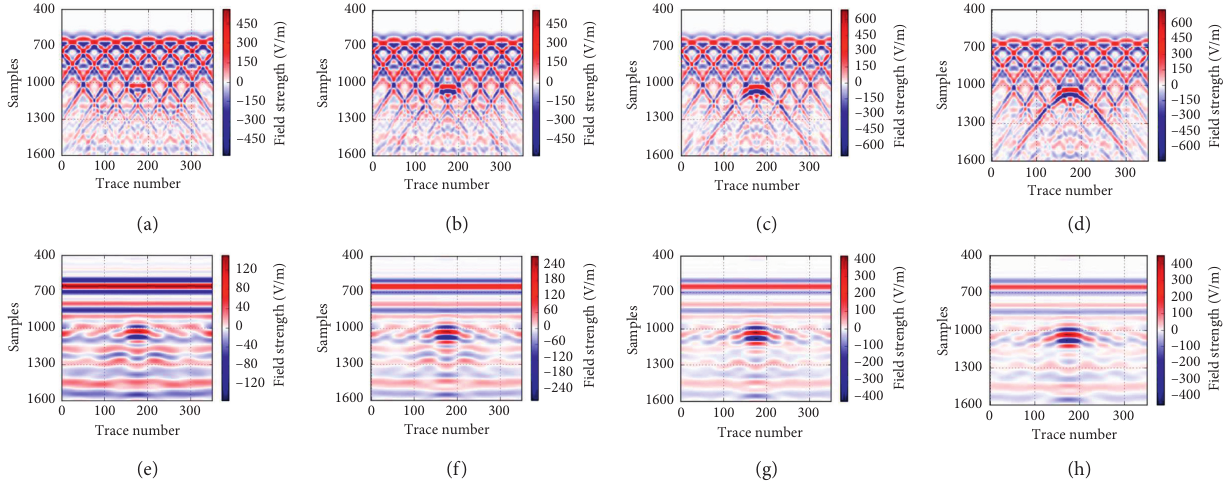
Figure 12: Forward and preprocessing results for rebar: (a) forward result, l l � 8cm; (d) forward result, l v preprocessing result of (d).